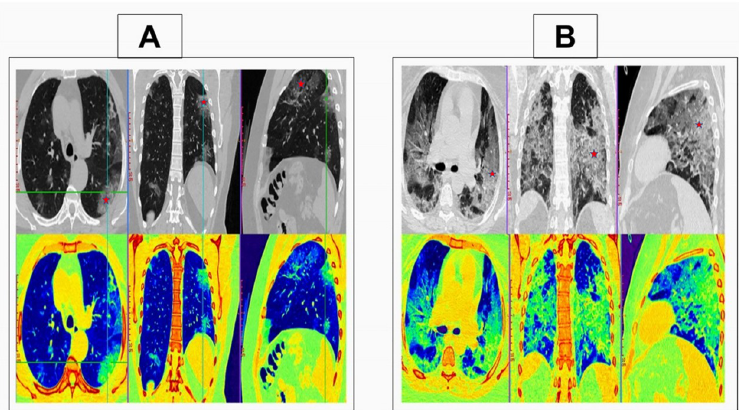
Fig 2. CT scan chest with multi-planar and color-coded images. (A) A 44 years old male patient presented with fever and cough. CT scan chest with multi-planar and color-coded images showed bilateral multi-focal patchy ground-glass opacities with a peripheral subpleural predominance (asterisk). CT severity score was 7. The patient exhibited a mild disease course. (B) A 30 years old male patient presented with fever, dyspnea, and cough. CT scan chest with multi- planar and color-coded images showed widespread bilateral central and peripheral confluent ground-glass opacities (asterisk). CT severity score was 21. The patient exhibited a severe disease